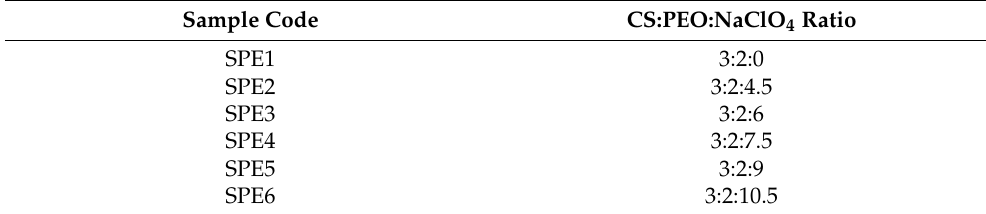
Table 1. Variation of CS/PEO/NaClO 4 ratio for salt